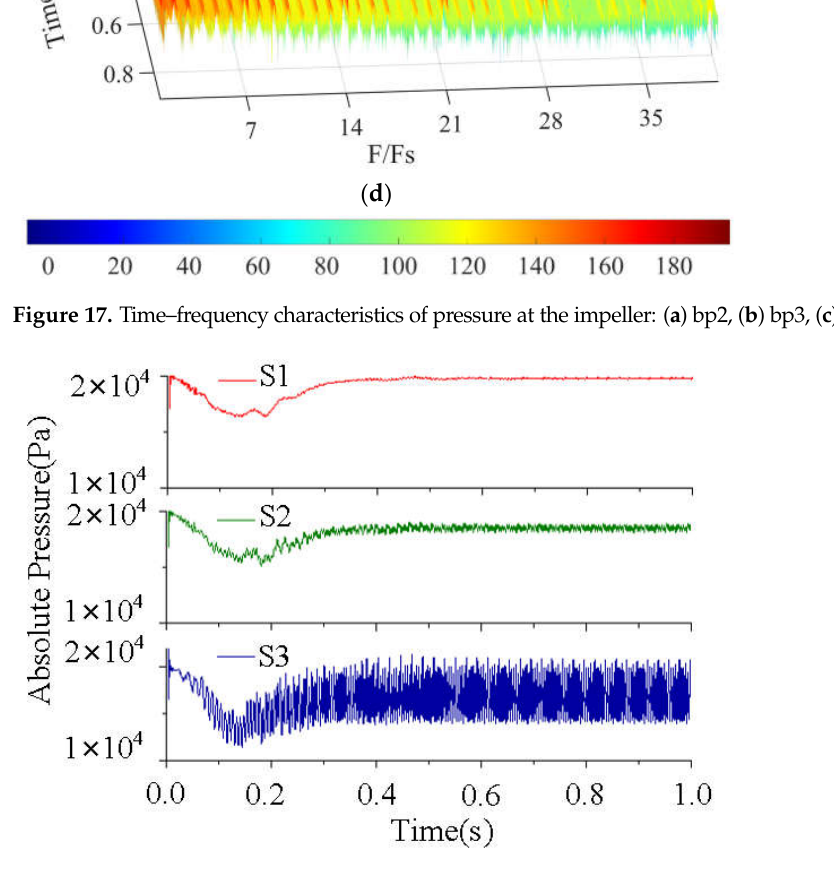
Figure 17. Time–frequency characteristics of pressure at the impeller: ( a ) bp2, ( b ) bp3, ( c ) bs2, and ( d ) bs3.